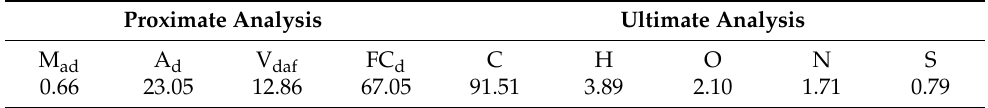
Table 1. Proximate and ultimate analysis of Jincheng